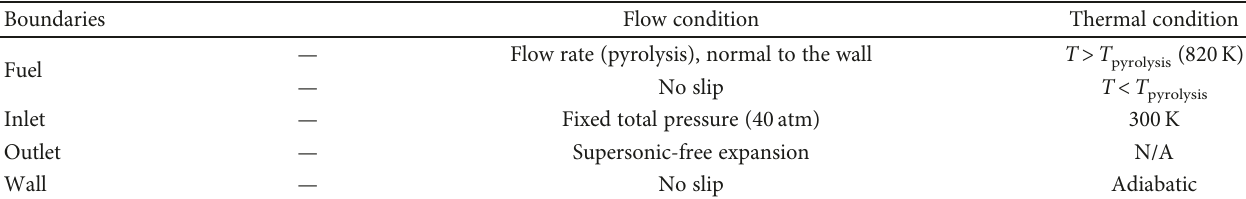
Table 2: Boundary settings for numerical